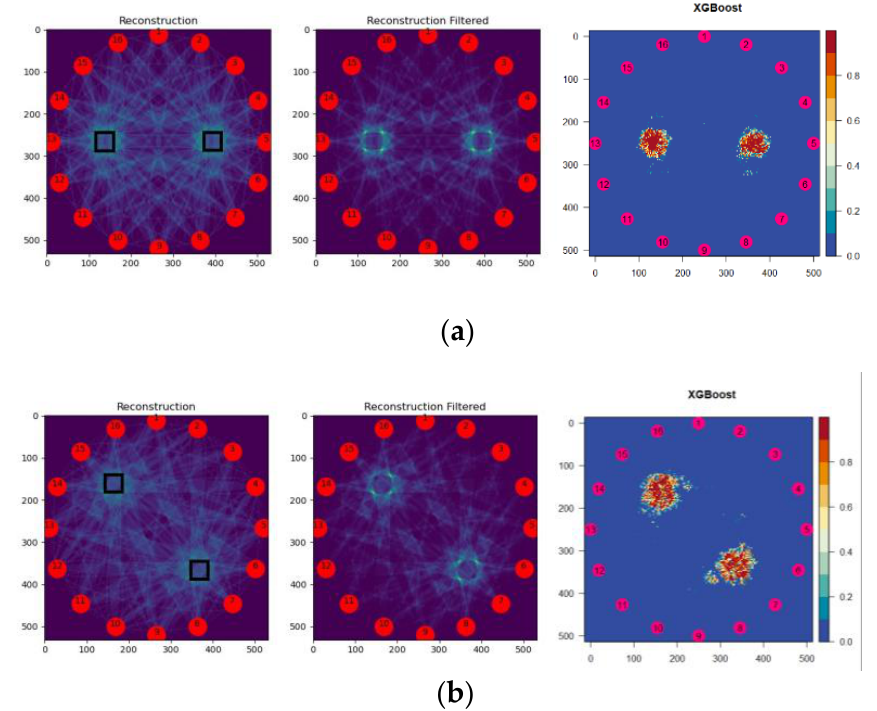
Figure 12. Each reconstructed object is labelled on the left graph, the filtered reconstruction obtained by the deterministic method is shown in the middle, and the reconstruction using the XGBoost model is shown on the right: ( a ) Two regular cuboids with base edge length 30 mm equidistant from the centre of the tank; ( b ) two regular cuboids with base edge length 30 mm equidistant from the centre of the tank (rotated through a 45-degree angle).